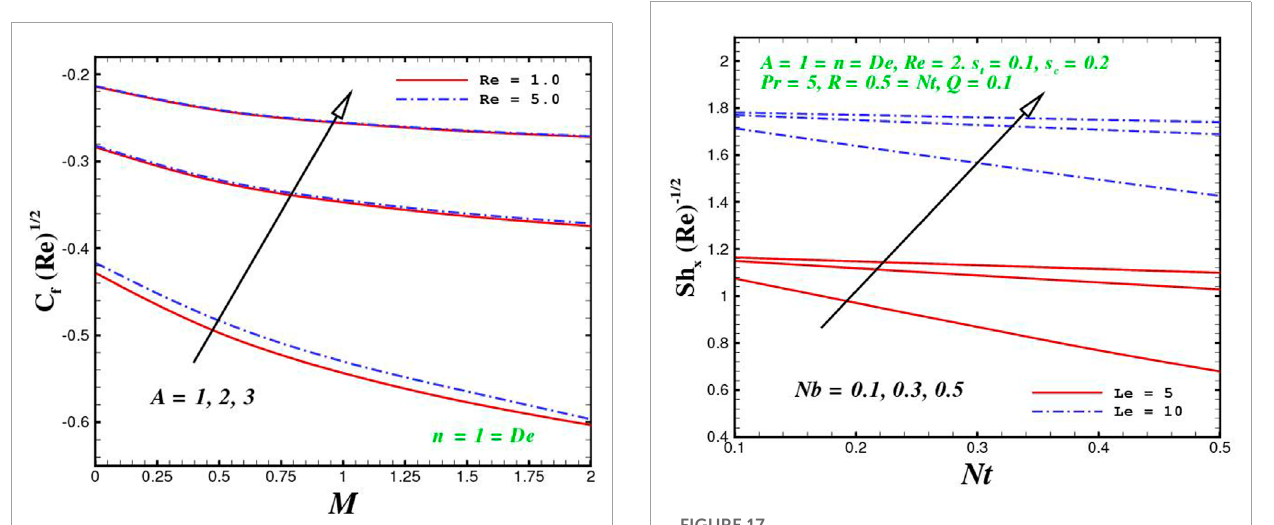
FIGURE 17 Shaerwood Sh x √ Re x , sketch for frequent values of Nb and